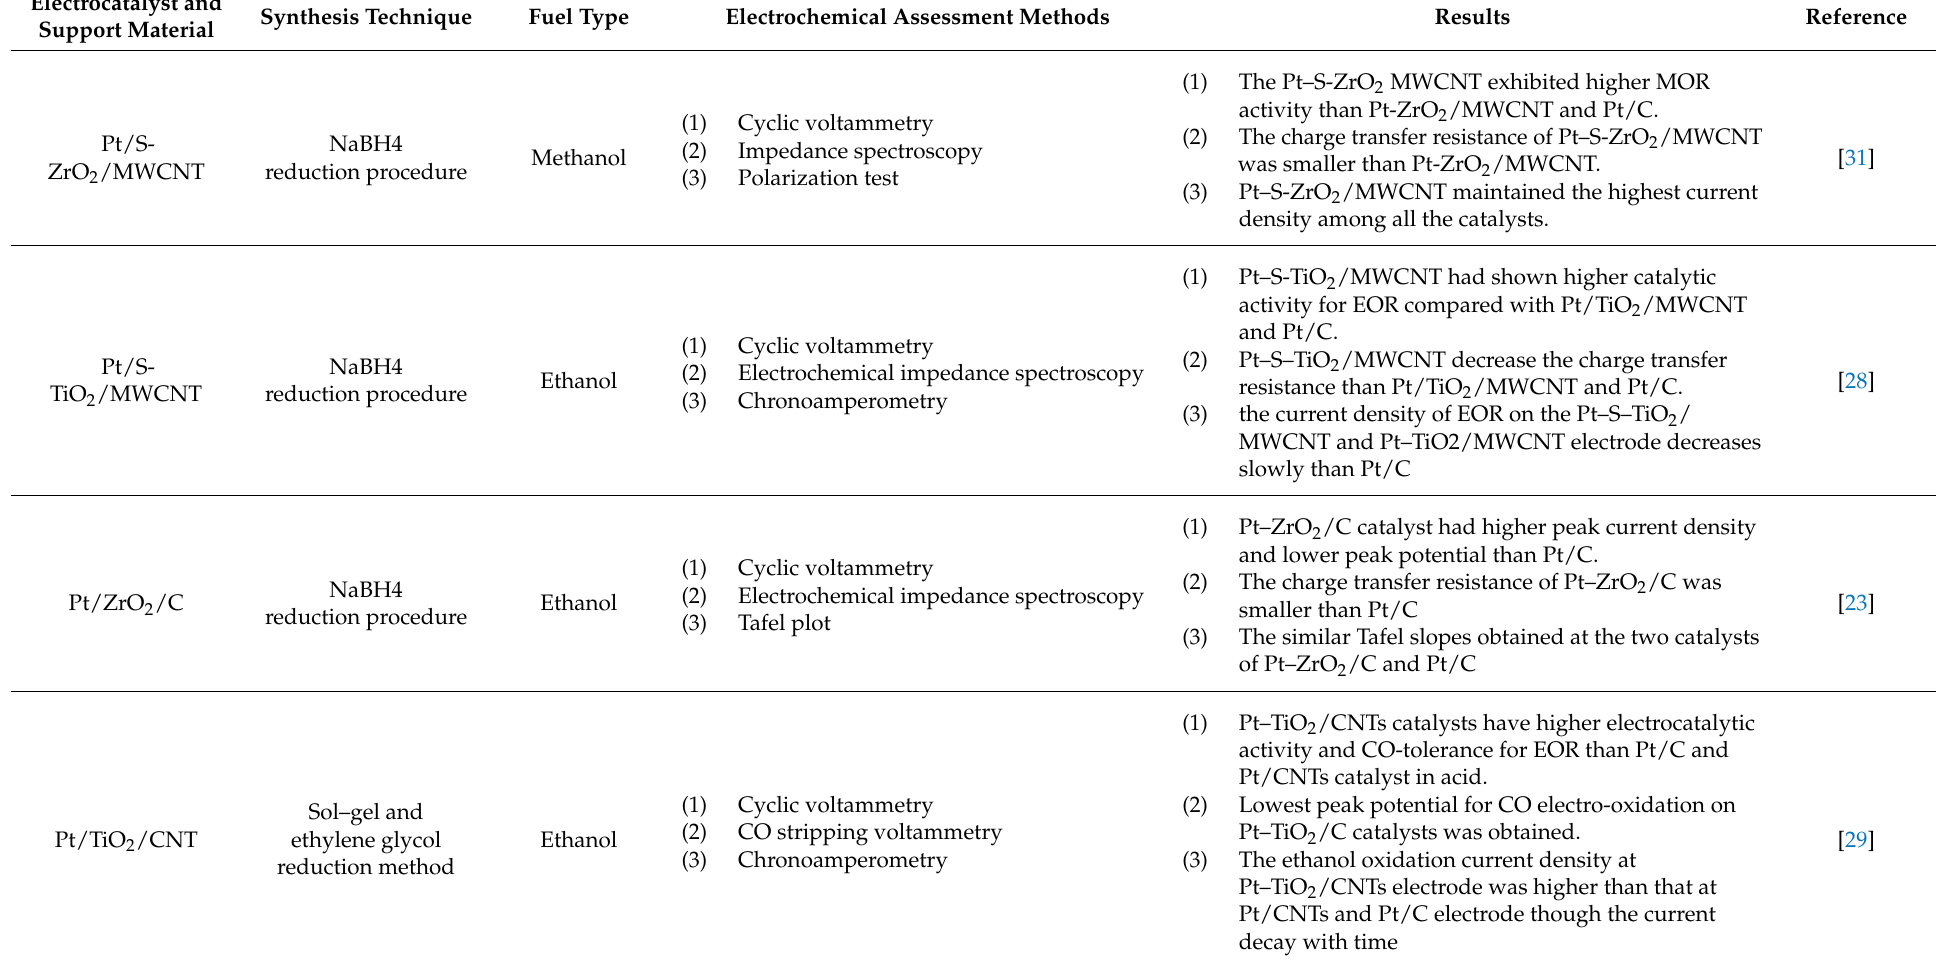
Table 1. Comparison between current work and earlier most relevant